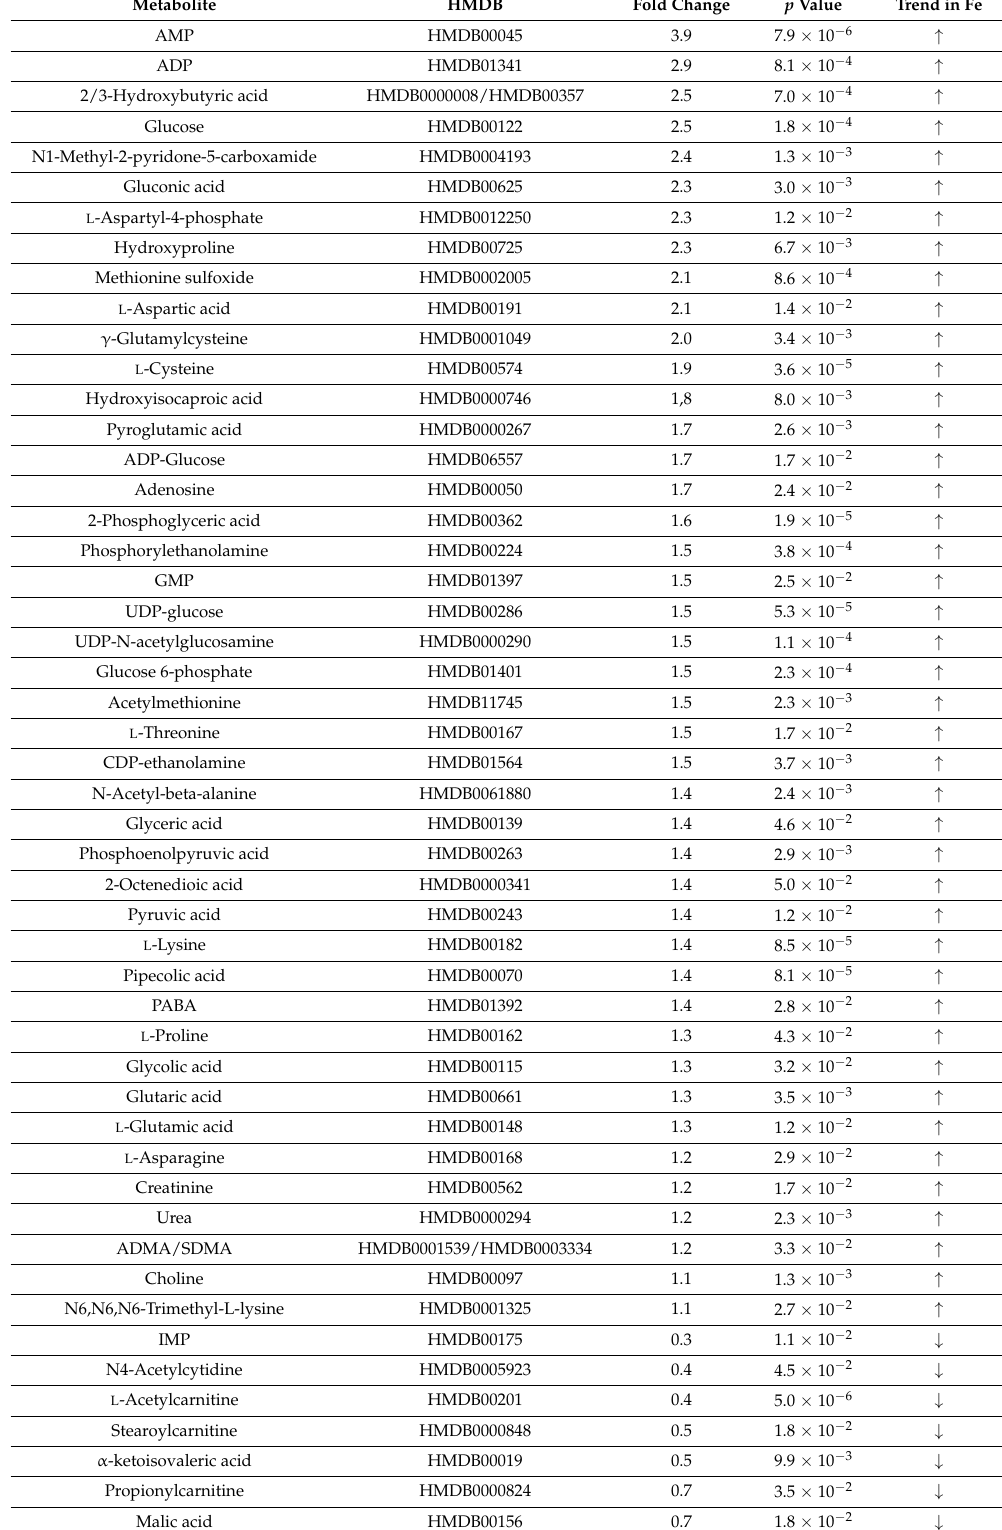
Table 1. Metabolites significantly changing (increasing ↑ , decreasing ↓ ) in peripheral blood after two weeks of a high-iron diet as compared to animals on a control diet. Controls (Ctrl, blue, n = 3), high-iron diet (Fe, orange, n = 5). Statistics: Student t -test was performed, fold-change was calculated and a p -value < 0.05 was considered to be